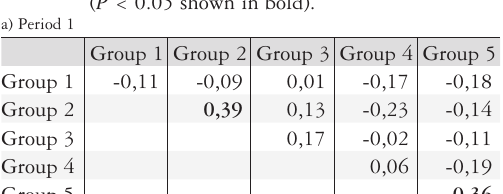
Table 1. Pearson’s correlation (synchronization) among the 6 groups, Finnmark, June 1999 for a) peri- od 1 and (b) period 3. Correlation coefficients ( P < 0.05 shown in bold). a) Period 1